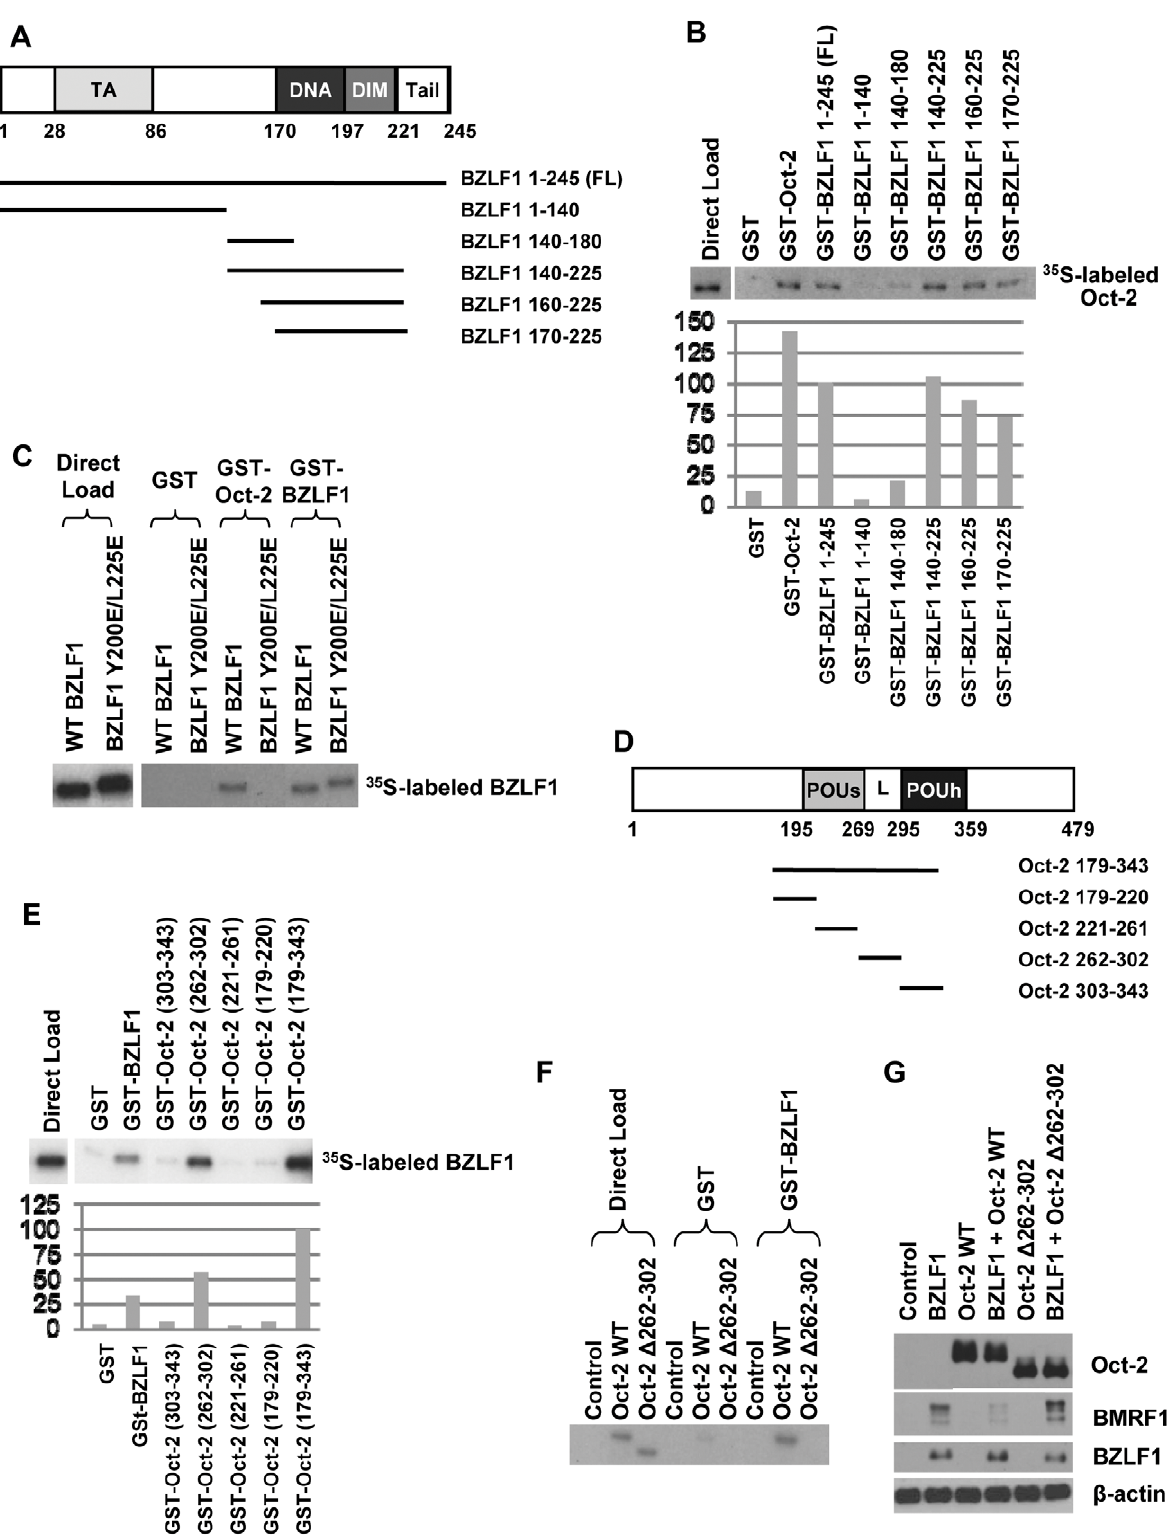
Figure 6. Oct-2 interacts with BZLF1 DNA-binding/dimerization domain, and BZLF1 interacts with Oct-2 POU domain. (A) Schematic of the BZLF1 protein transcriptional activation (TA), basic DNA-binding (DNA), dimerization (DIM), and C-terminal tail (Tail) domains. Numbers represent amino acid positions. Full-length (FL), as well as various BZLF1 truncation proteins used in subsequent GST pull-down assays are also depicted. (B) GST pull-down assays were performed using GST, GST-Oct-2, or various GST-BZLF1 truncation fusion proteins incubated with 35 S- labeled, in vitro -translated Oct-2 protein. Twenty percent of the direct load was used for autoradiography. The amount of Oct-2 binding in each